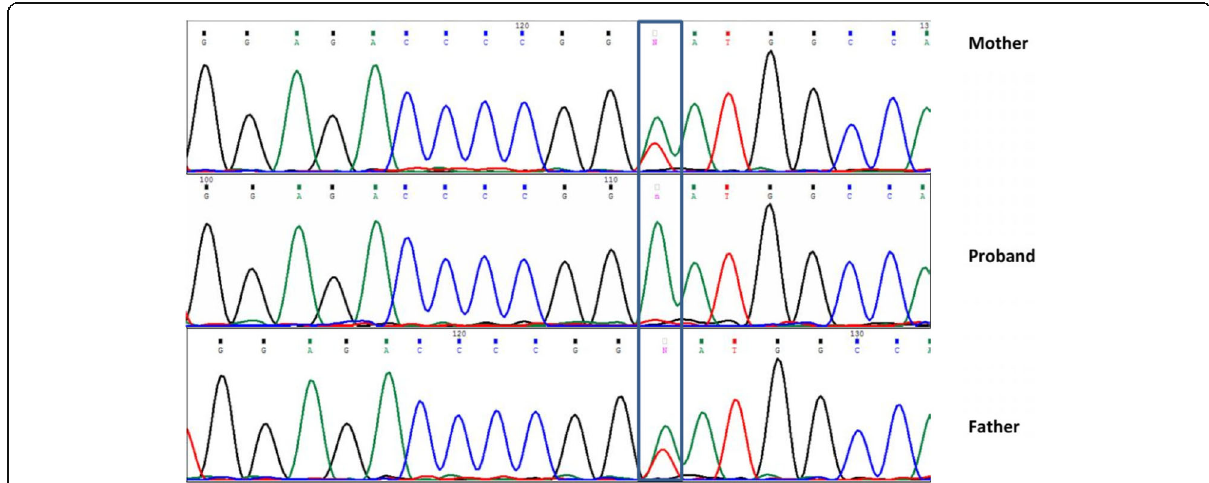
Fig. 2 Sanger sequencing chromatogram of AIRE gene (part of intron 9), which indicated a homozygous and heterozygous c.1095 + 2 T > A mutation in the proband and her parents, respectivley